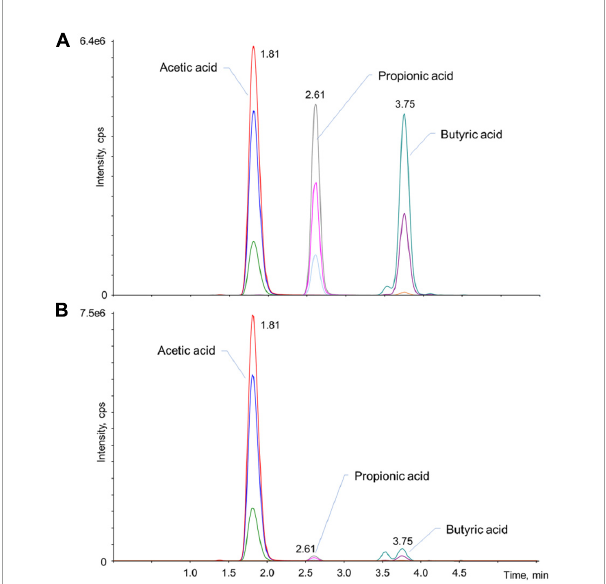
FIGURE1 Representative chromatograms of the analytes in a standard mixture (1 µ g/mL acetic acid, 200 ng/mL propionic, and butyric acids) (A) and in one of the real samples (B) . For each analyte, three multiple reaction monitoring (MRM) transitions were monitored: the one with the higher signal/noise ratio, which usually correspond to the most intense trace, was used for the quantification of the analyte (Q), while the other two transitions confirmed that the peak is attributable to the analyte (q). All MRM transitions are summarized in Supplementary Table 1